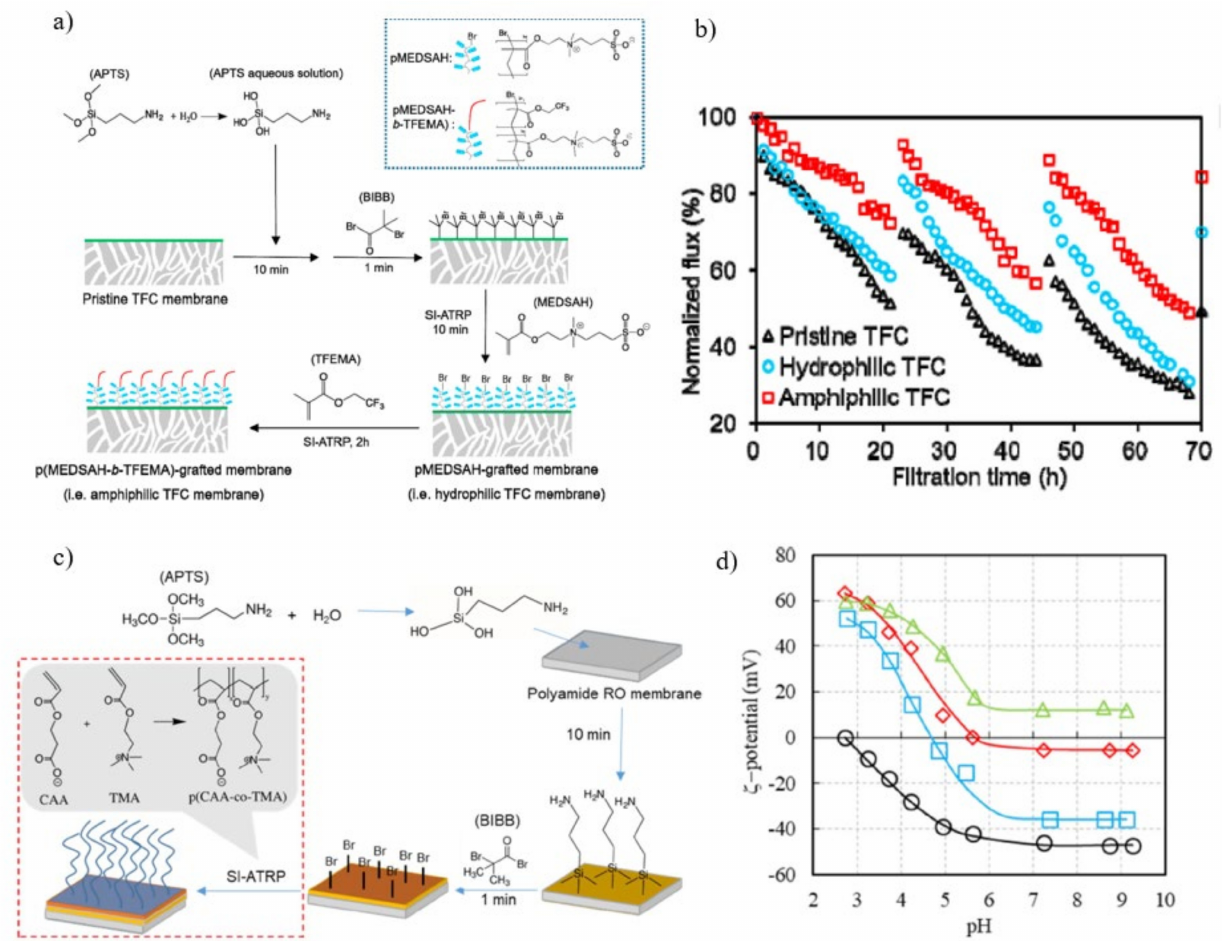
Figure 13. ( a ) Schematic illustration for the amphiphilic p(MEDSAH- b -TFEMA)-grafted membrane fabrication through dual SI-ATRP; ( b ) The flux of pure TFC, hydrophilic TFC, and amphiphilic TFC membranes was shown as a function of filtration time during biofouling [142]; ( c ) Schematic illustration of the fabrication of the p(CAA-co-TMA)-grafted membranes by the SI-ATRP method; ( d ) Zeta-potential of membrane as a function of pH (Black = RO, Blue = CAA:TMA ratio of 6, Red = CAA:TMA ratio of 3, Green = CAA:TMA ratio of 1)